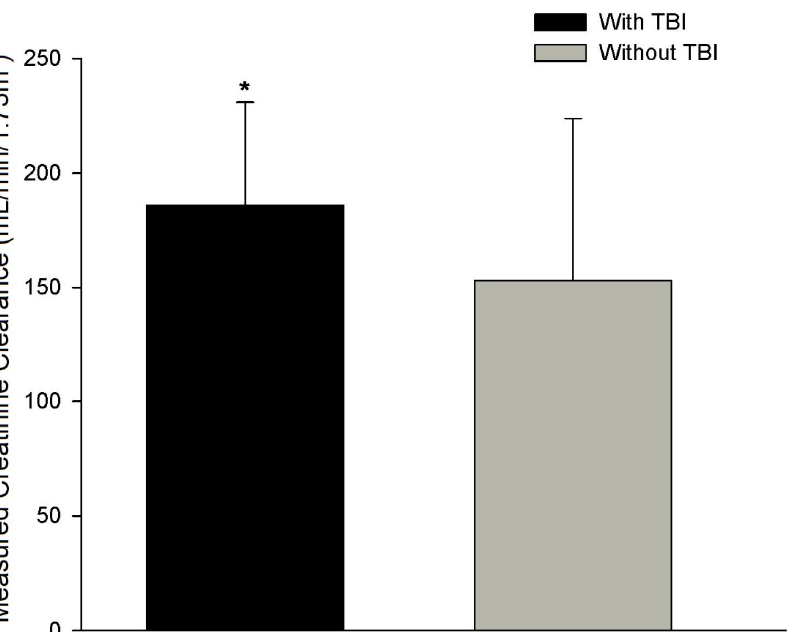
Figure 1. Measured creatinine clearance in patients with and without severe traumatic brain injury (TBI). * p = 0.004.